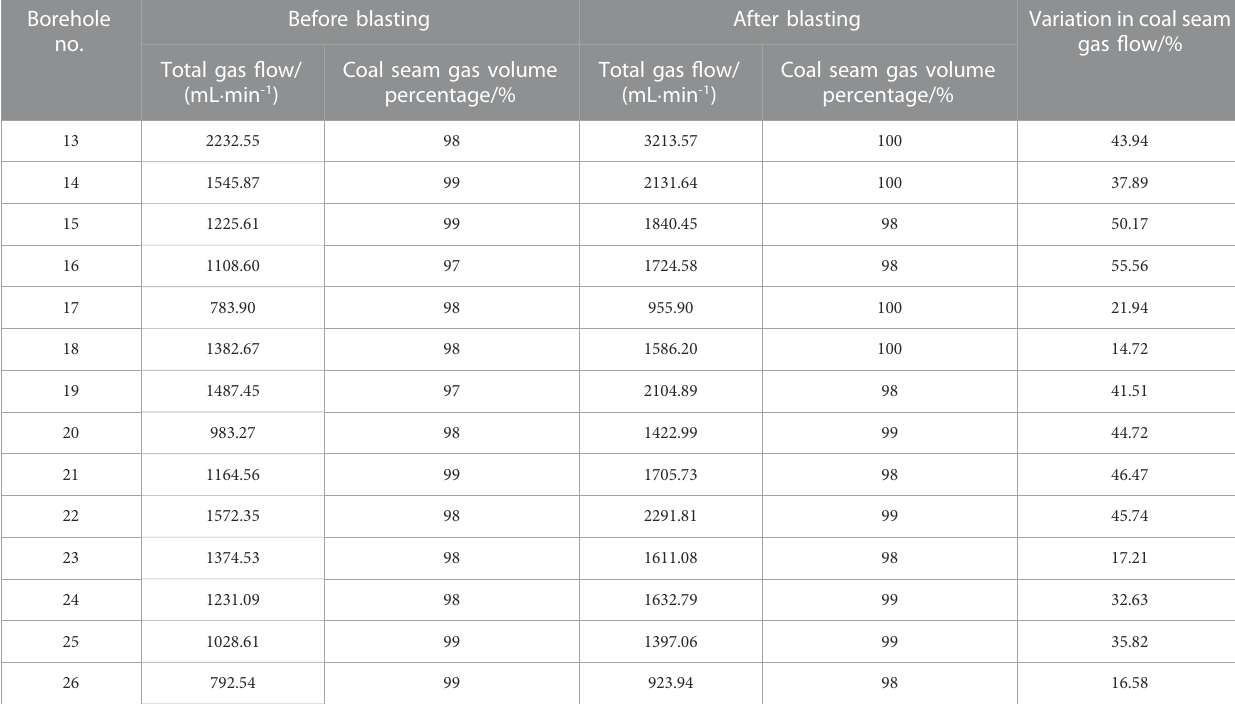
TABLE 1 Variation in coal seam gas fl ow before and after the compressed air blast. Borehole